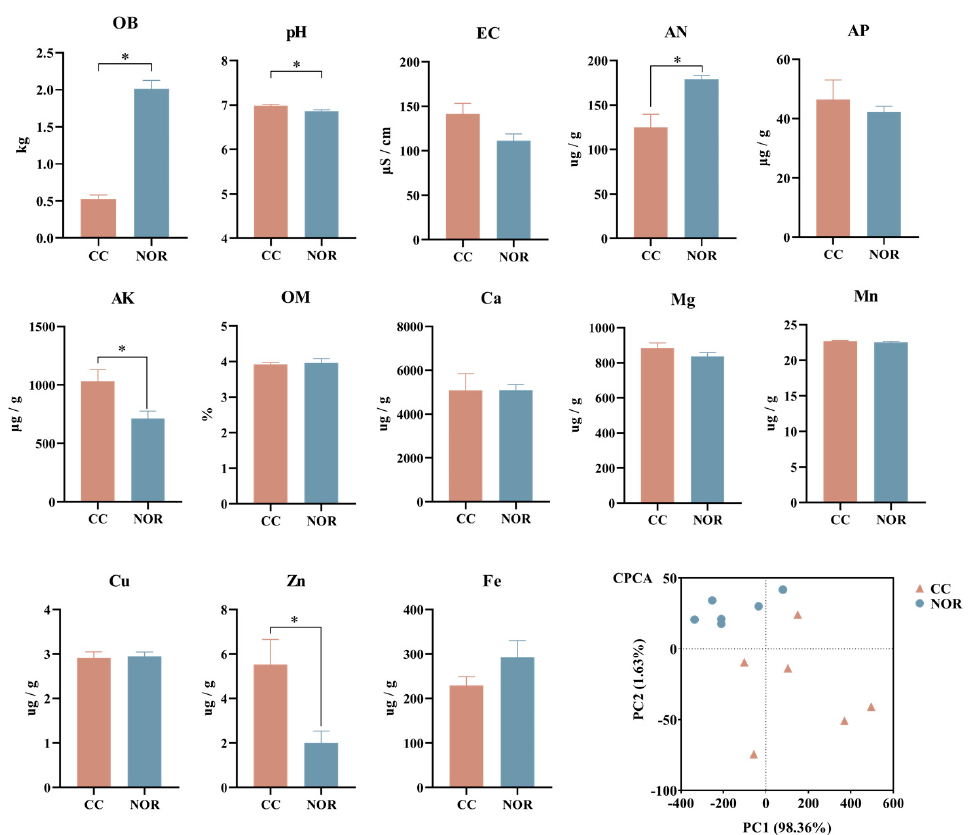
Figure 1. Above–ground biomass of plants and physicochemical properties of rhizosphere soil. OB: above–ground biomass of tobacco; pH: hydrogen ion concentration; EC: electric conductivity; AN: available nitrogen; AP: available phosphorus; AK: available potassium; OM: organic matter; Ca: calcium; Mg: magnesium; Mn: manganese; Cu: copper; Zn: zinc; Fe: iron; CPCA: principal component analysis (PCA) based on pH, AN, AK, and Zn was based on the variance–covariance matrix; CC represents continuous cropping obstacle field tobacco; NOR represents normal field tobacco; Asterisk (*) indicates significant differences ( t -test, p < 0.05). Error bars are standard